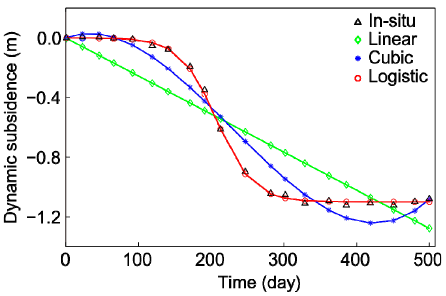
Figure 10. Comparison of the fitted dynamic subsidence using the linear, cubic polynomial, and logistic models.